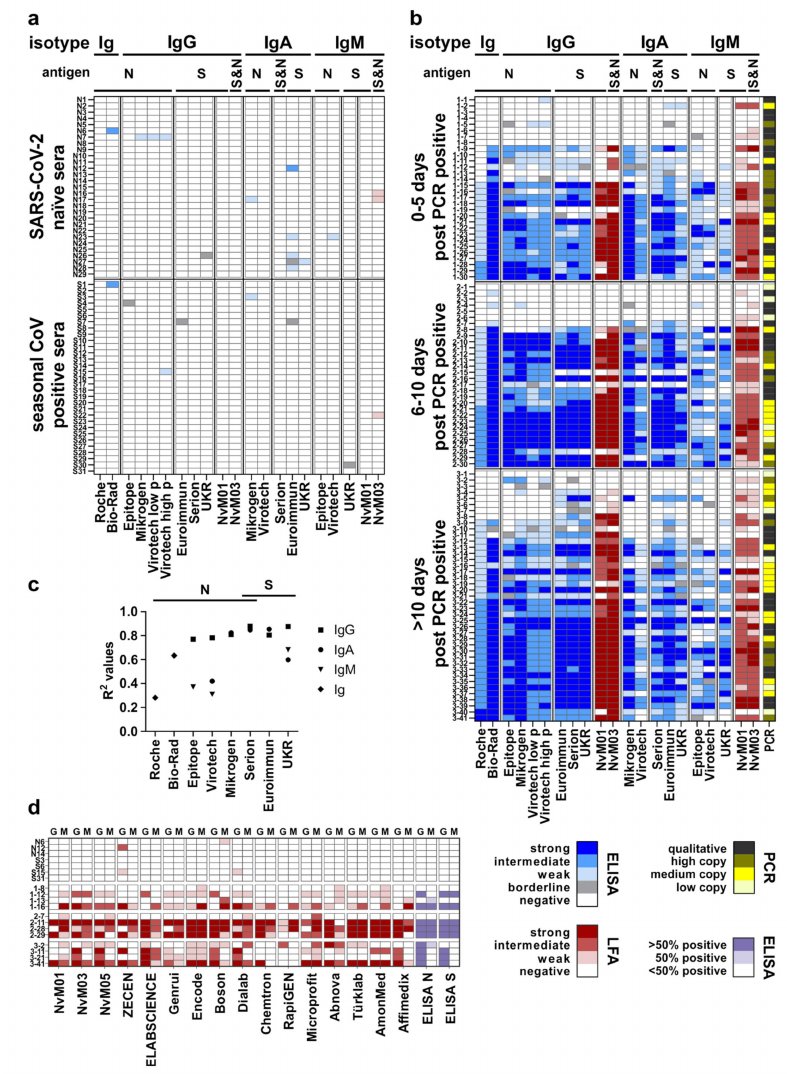
Figure 1. ( a ) Results from validation of the tested ELISAs and two LFAs with a panel of SARS-CoV-2 naïve and seasonal CoV-positive sera. ( b ) Assay results applying a SARS-CoV-2 PCR-positive serum panel. ( c ) Correlation of the different ELISA/ECLIA results with virus neutralization. Coefficients of determination (R 2 ) were calculated and plotted for every test and detected isotype (symbols see legend). ( d ) Results from evaluation of the tested LFAs (G = IgG; M =